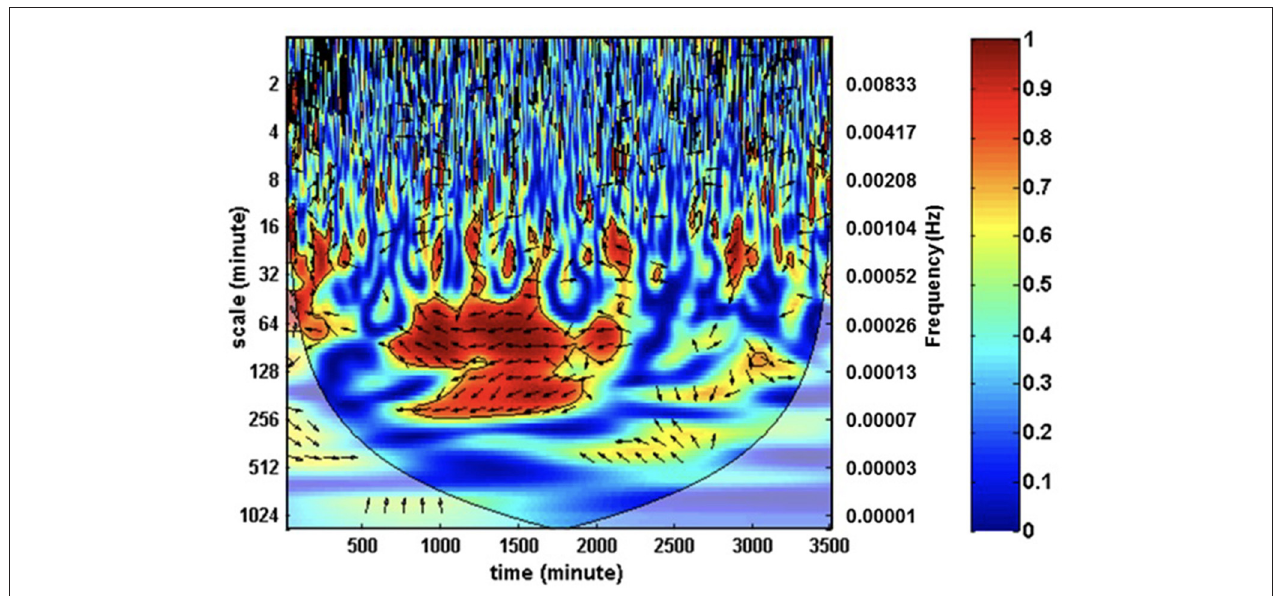
FIGURE 2 | Wavelet transform coherence analysis can be used to characterize cross-correlations between mean arterial pressure and ScO 2 as a function of a wide range of both time and frequencies. The coherence depicted by color mapping represents the correlations across the time-frequency axis and can be translated into percent coherence from 0 (least coherent, blue) to 1 (most coherent, red). In-phase coherence indicates impaired cerebral